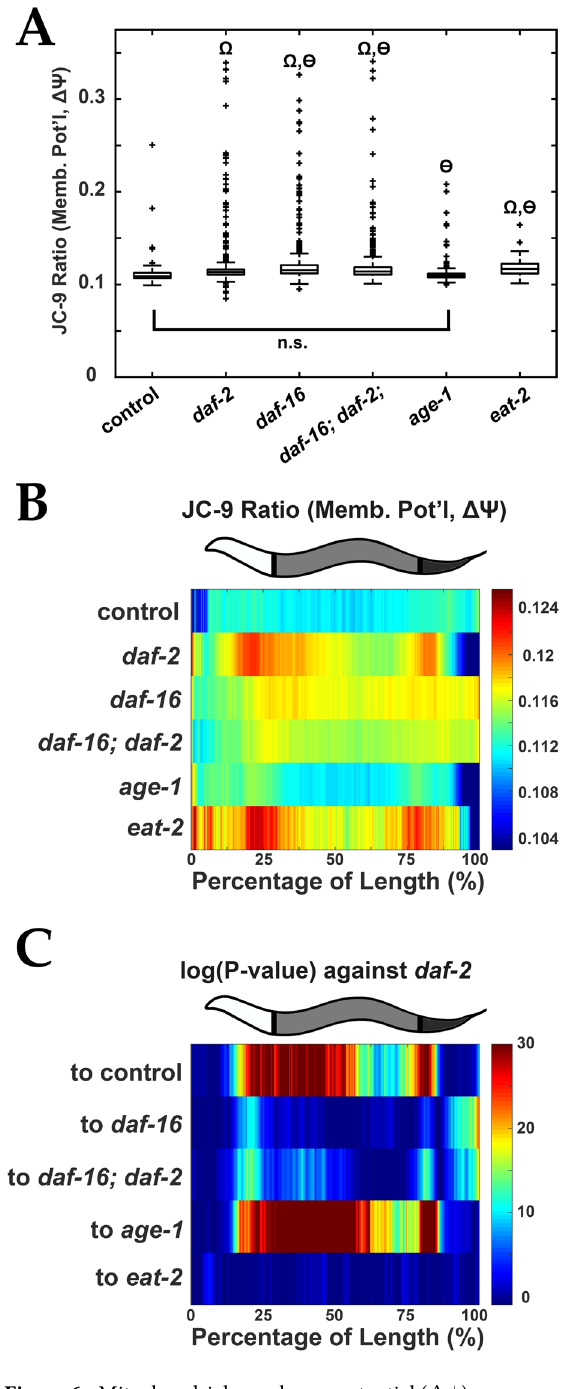
Figure 6. Mitochondrial membrane potential ( Δψ ) measurement of C . elegans longevity mutants. ( A ) Quantification of Δψ (by JC-9 ratio) for various long-lived nematode mutants. Wilcoxon Rank Sum tests were performed against N2 control (Ω = P < 0.00001) or against daf-2 (ѳ = P < 0.00001) strains. ( B ) Median profiles displaying spatial distribution of JC-9 ratio of C . elegans longevity strains. ( C ) Significance (log 10 ( P-value )) plots derived from median profiles in ( B ) comparing each profile to daf-2 nematodes. For significance plots a value ≥ 0 is equivalent to P ≤ 0.05 by Wilcoxon Rank Sum Test. All animals are positioned with the anterior side to the left. Plots are representative of three biological replicates and derived from n ≥ 50 organisms. Sample size ( n ) for all experiments and exact P-values can be found in the Supplementary Table. L.A. Daniele provided the